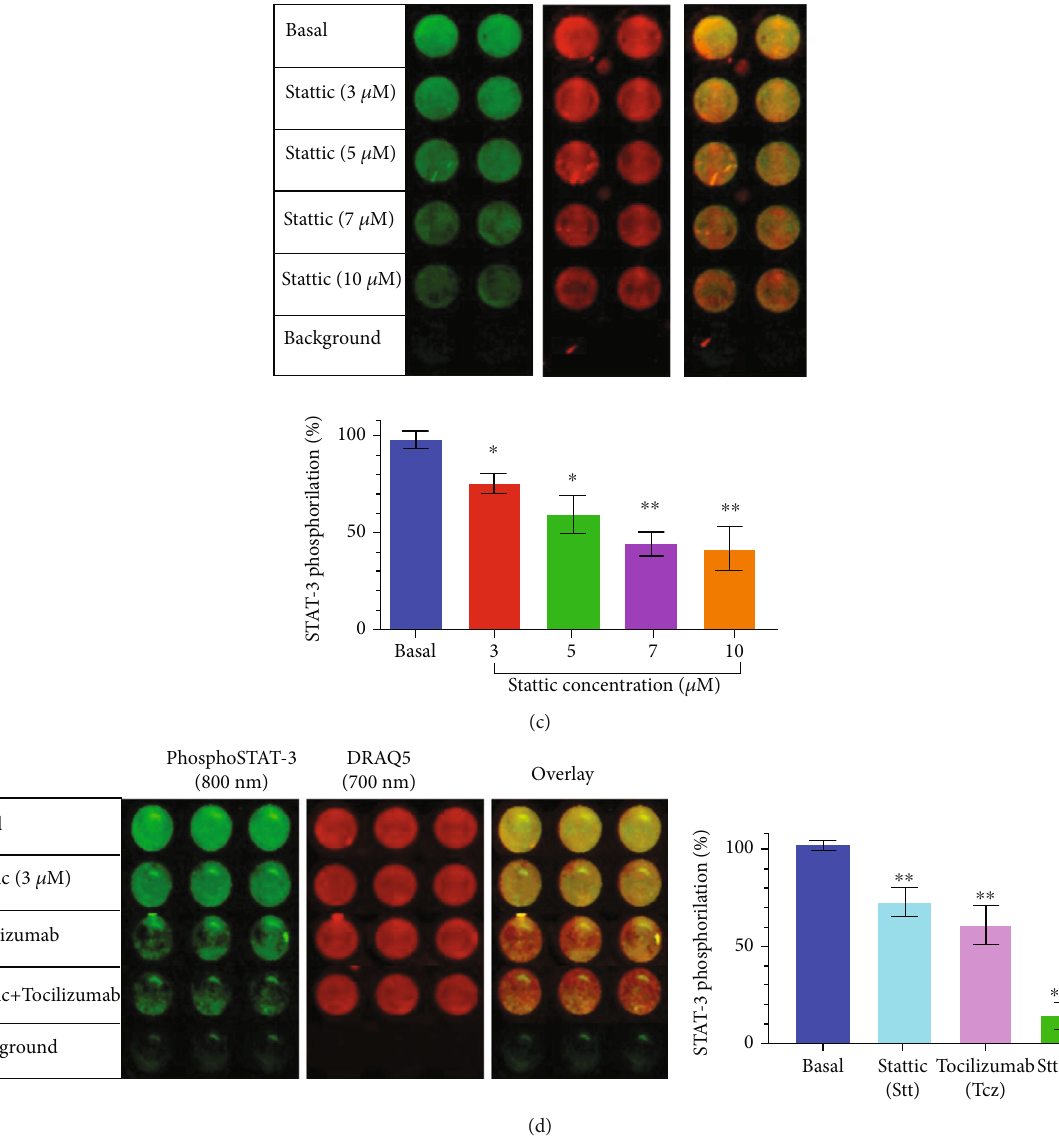
Figure 3: Stattic and tocilizumab combination increase pSTAT-3 dephosphorylation in DU145 cells. The cells were cultured with the di ff erent treatments according to the corresponding groups for 24 h. (a) IL6R/STAT-3 axis expression was compared between PCa cell lines using 50 μ g of protein by Western blot; the presence of constitutive pSTAT-3 expression was shown in the DU145 line only; protein expression was then veri fi ed by in-cell Western. (b) Use of treatment with Stt causes a decrease in metabolic activity with concentrations greater than 5 μ M. (c) The e ff ective Stt decrease is only shown at concentrations above the IC50. (d) The combined treatments with Tcz allow a lower Stt concentration than the IC50 with greater e ffi ciency in the dephosphorylation of pSTAT-3. All experiments were repeated at least three times. Data are shown as the mean ± SD . ∗ p < 0 : 05 , ∗∗ p < 0 : 01 , ∗∗∗ p < 0 : 001 ; (unpaired t -test) against the basal group. Stt: stattic; Tcz: